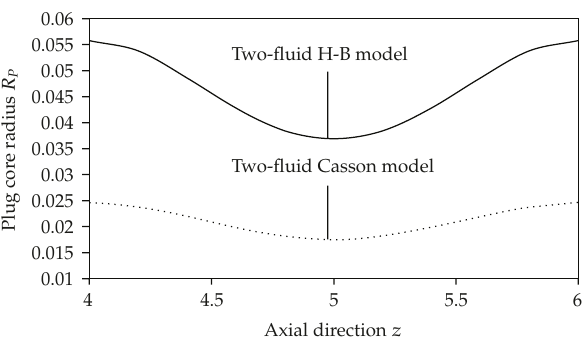
Figure 3: Variation of plug core radius with axial distance of the two-fluid Casson and Herschel-Bulkley models.